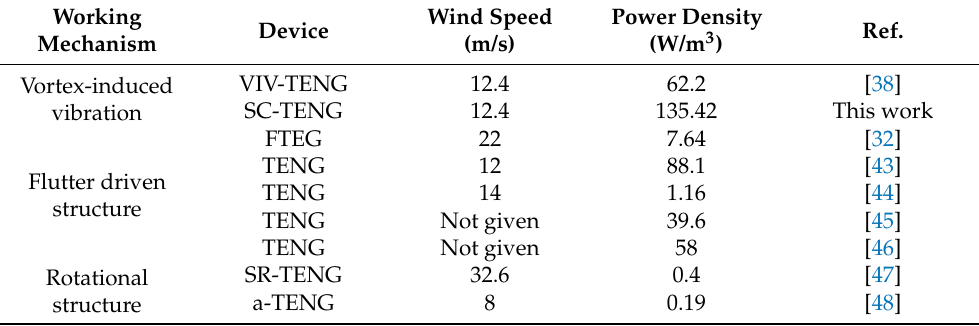
Figure 4. ( a – c ) Dependence of the output performance of the SC − TENG with K = 27 N/m on the Figure 4. ( a − c ) Dependence of the output performance of the SC − TENG with 𝐾 = 27 N/m on the wind velocity; ( d – f ) dependence of the output performance of the SC − TENG with K = 55 N/m on wind velocity; ( d − f ) dependence of the output performance of the SC − TENG with 𝐾 = 55 N/m on the wind velocity; ( g – i ) dependence of the output performance of the SC − TENG with K = 90 N/m the wind velocity; ( g − i ) dependence of the output performance of the SC − TENG with 𝐾 = 90 N/m on the wind velocity. on the wind velocity. Table 3. A summary of the output performance of various wind energy harvesting